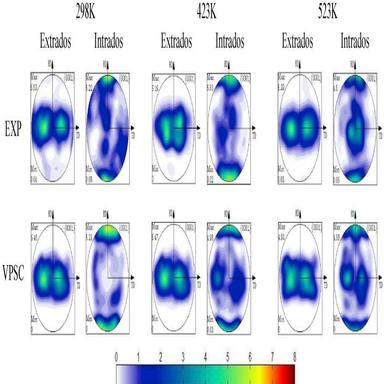
Comparison of the experimental textures and the predicted ones for the α-Ti tube, indicating that the reorientation of the c-axes of grains towards the RD in the intrados and the bimodal distribution of the pole figures in the extrados can be captured using the calibrated VPSC model.